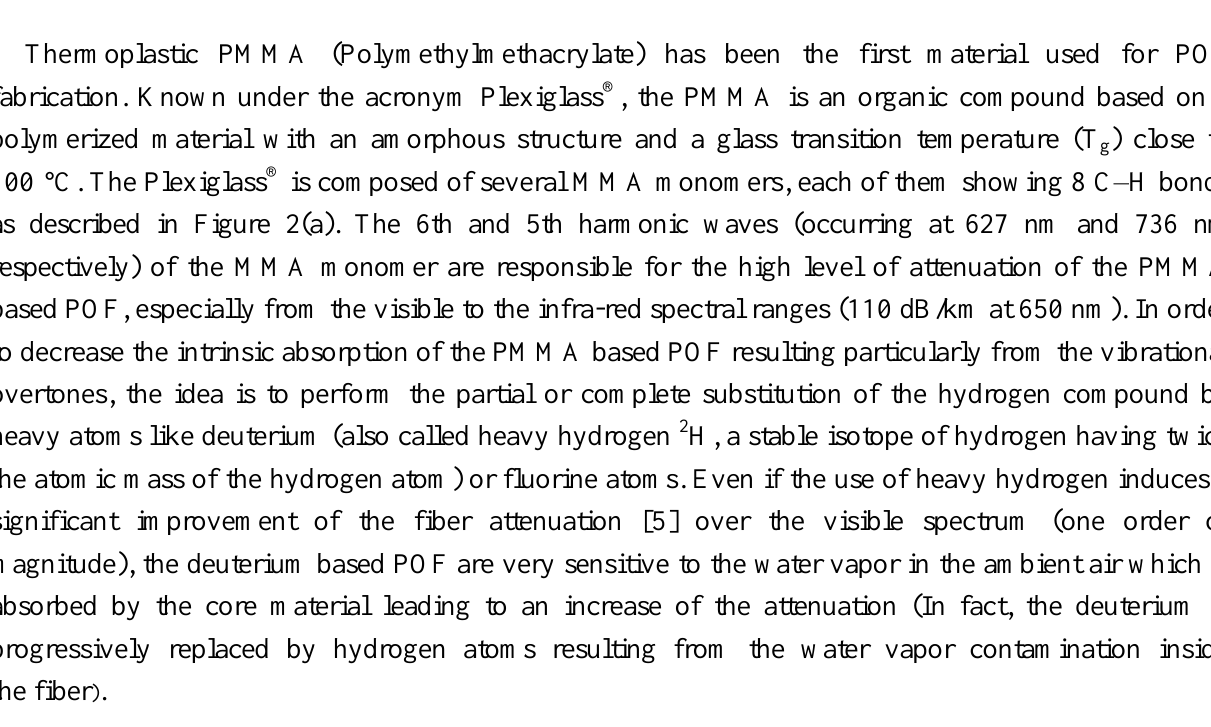
Figure 2. Molecular geometry and bonding of the Plexiglas ® ( a ) and the CYTOP ® ( b )